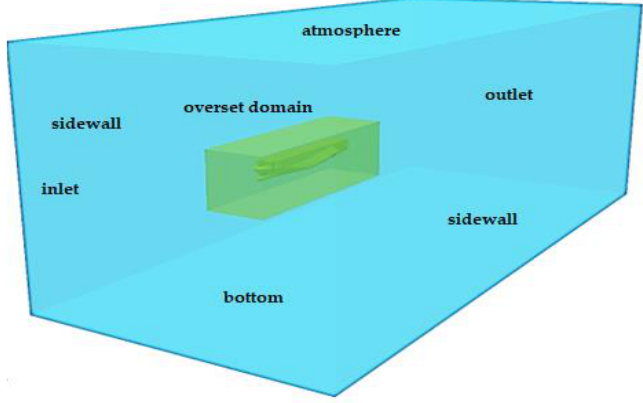
Figure 11. CFD computational domain with relevant boundary faces.